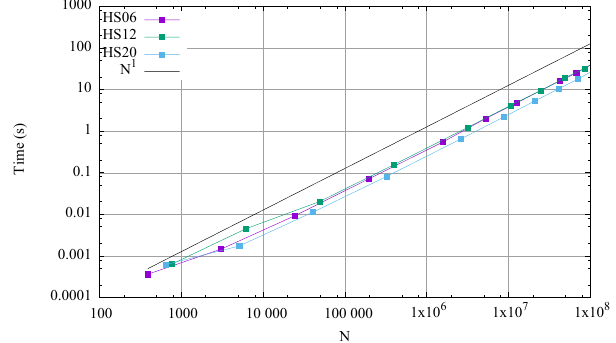
Figure 4. Measured times to build and assemble the mesh as a func- tion of its number of nodes ( N ).